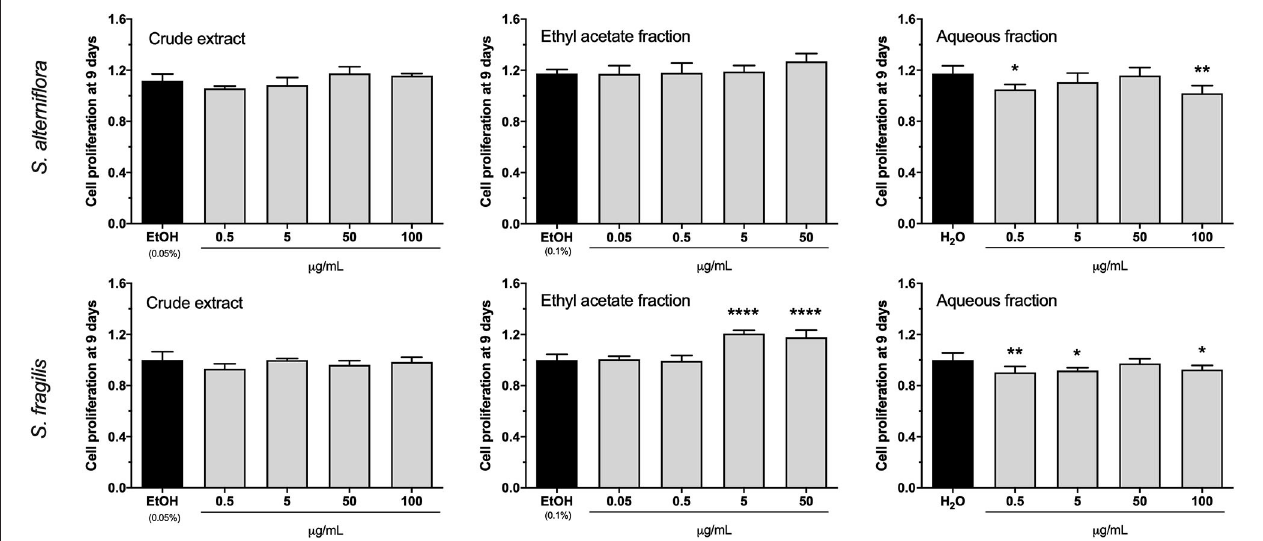
FIGURE 1 | Proliferative activity of S. alterniflora (upper panel) and S. fragilis (lower panel) extracts in vitro . VSa13 cells were exposed for 9 days to the crude extracts (0.5, 5, 50, 100 µ g/mL), ethyl acetate fractions (0.05, 0.5, 5, 50 µ g/mL) or aqueous fractions (0.5, 5, 50, 100 µ g/mL) of each plant, or to the respective vehicles (0.05% ethanol, 0.1% ethanol and water). Results are presented as fold-change over the control value (set to 1). Values are presented as mean ± standard deviation ( n = 5). Asterisks indicate values significantly different from the control values (one-way ANOVA followed by Dunnett’s multiple comparison test; * p < 0.05, ** p < 0.01, **** p < 0.0001).